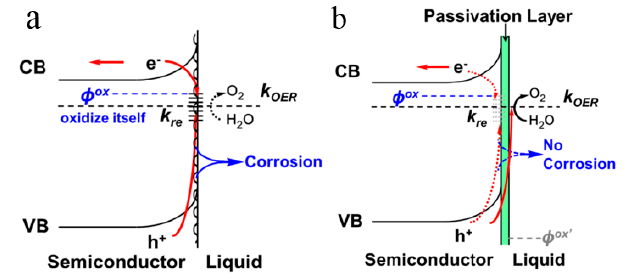
Figure 19. Band structure of an n-type semiconductor photoelectrode experiencing corrosion ( a ) when contacting an aqueous electrolyte; ( b ) with passivation layer without corrosion. ϕ ox is the corrosion potential of the n-type semiconductor; and ϕ red is the corrosion potential of the p-type semiconductor. Corrosion may reduce the light absorption and/or generate more surface defect states. Reprinted with permission from ref. [71] Copyright 2014. The Royal Society of Chemistry.